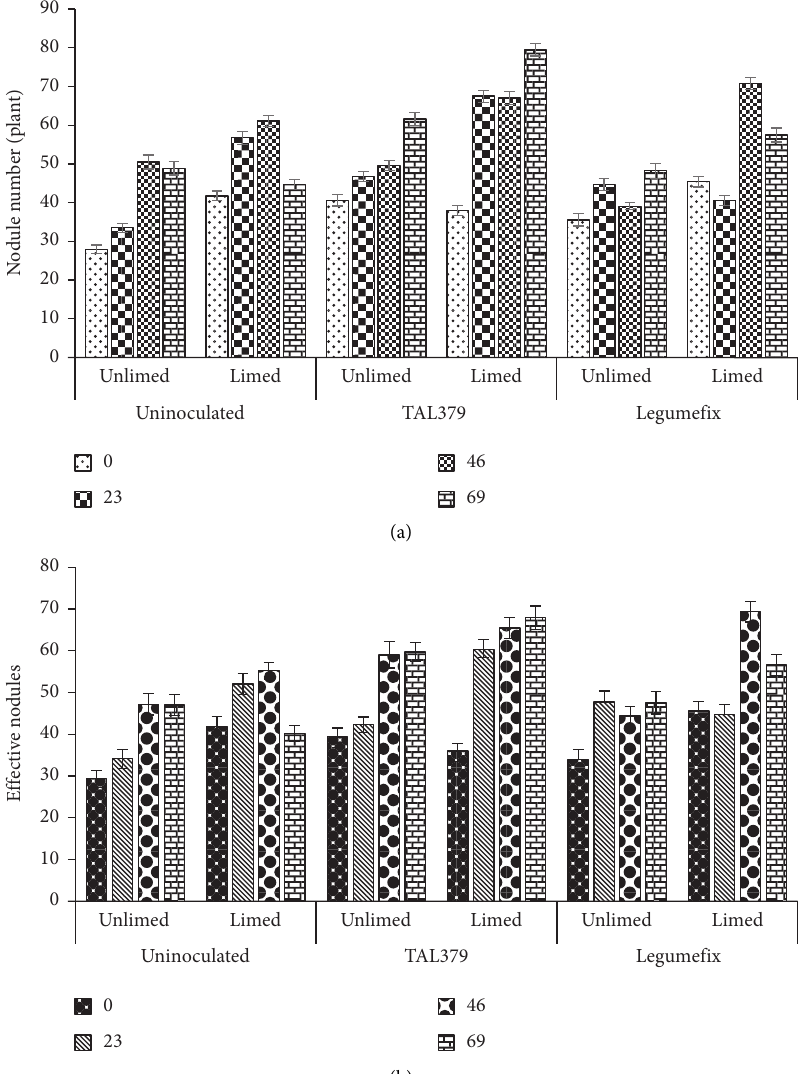
Figure 2: Interaction effect of Bradyrhizobium × lime × phosphorus application on (a) the number of nodules per plant and (b) the number of effective nodules per